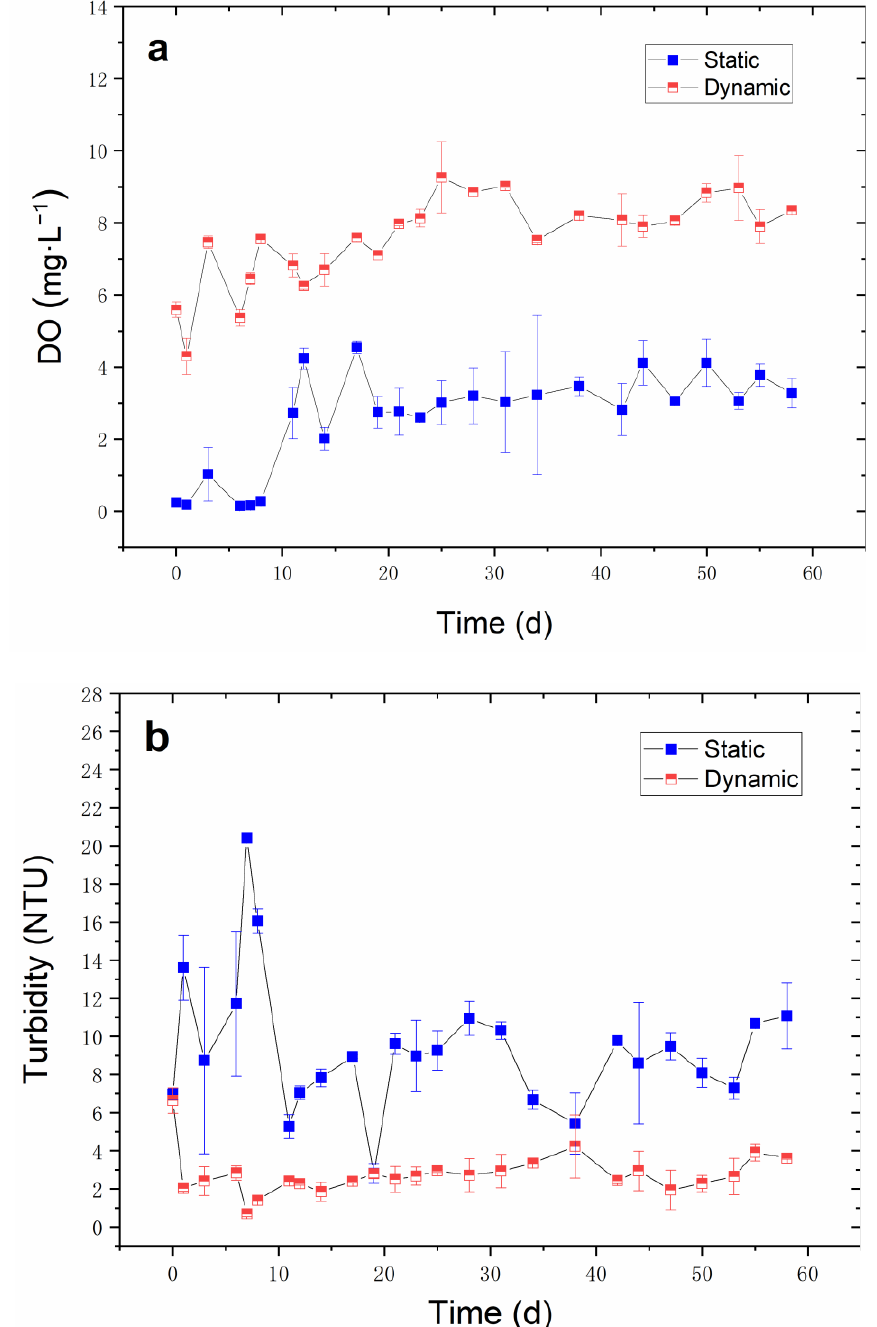
Figure 3. Effects of water flow velocity (35 cm·s − 1 ) on nutrient-rich simulated water. ( a ) DO (mg·L − 1 ) and ( b ) turbidity (NTU) during the 60-day cultivation period. All data had a mean value of ± SD.